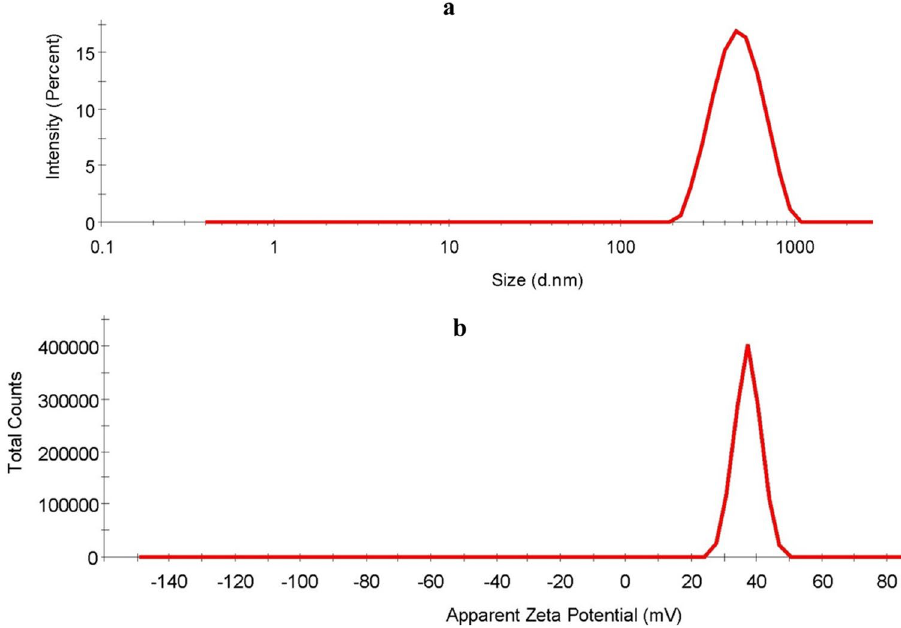
Figure 1. DLS analysis of Cu-chitosan NPs ( a ) size distribution by intensity and ( b )